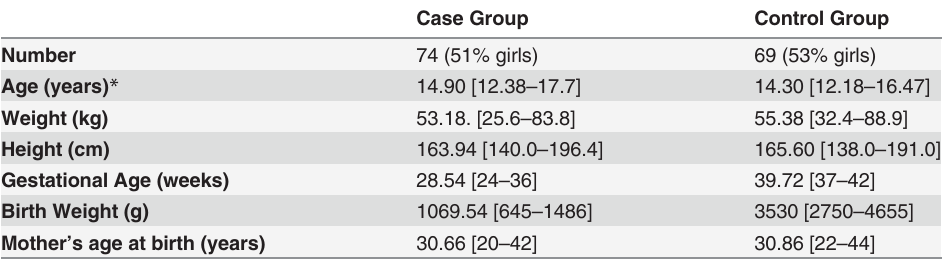
Table 1. Description of the two groups compared in this